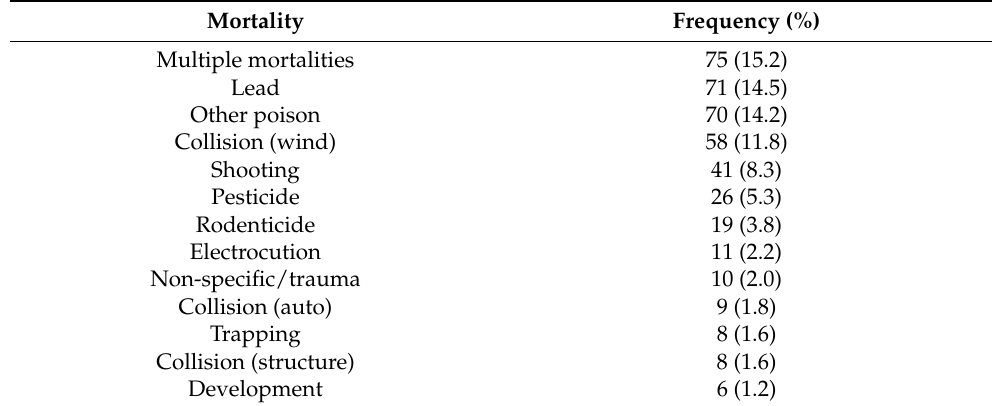
Table 3. Mortality types and frequencies documented within the reviewed human-raptor interac- tion research.